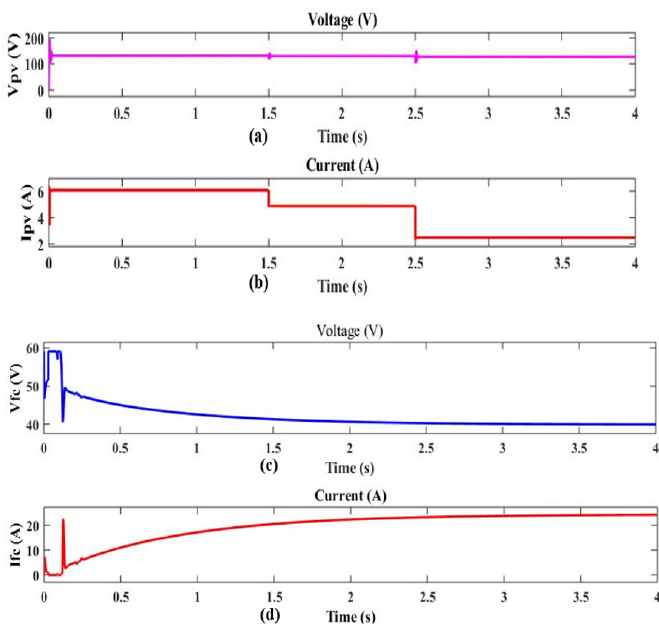
Figure 11. Without MPPT—( a ) PV Voltage ( b ) PV Current ( c ) Fuel cell current ( d ) Fuel cell voltage.